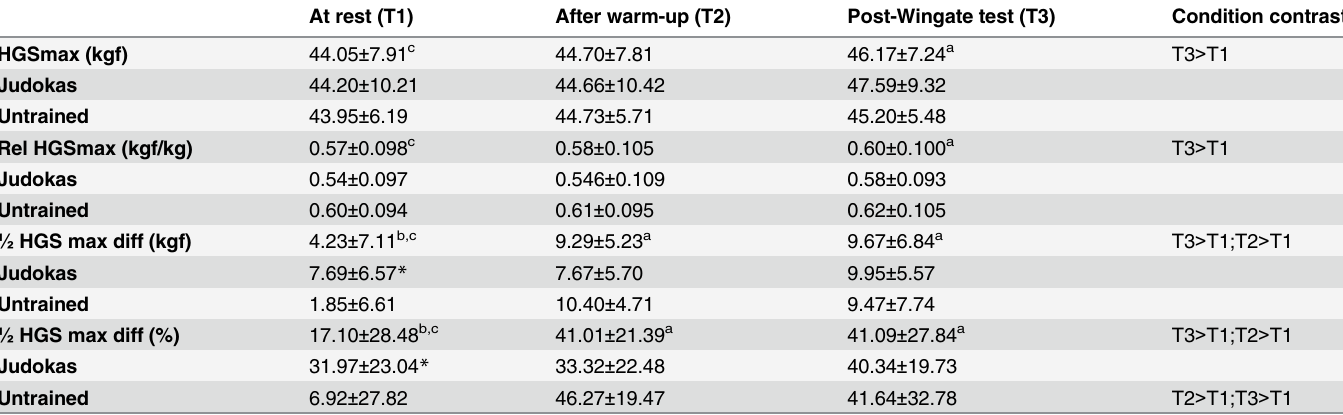
Table 5. Maximal hand grip strength and accuracy of perceived half level of strength changes after the Wingate-test (mean ± SD). At rest (T1) After warm-up